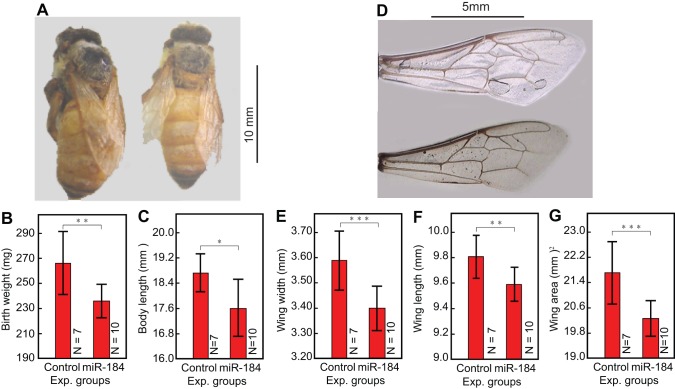
Morphological changes in honeybees treated with miR-184.Comparison between morphological characteristics of newly emerged adults of the miR-184 treated group and the control group: a). the miR-184 treated adult bee (right) and the control adult bee (left); b). the birth weight was significantly reduced by feeding miR-184 in larval food (F2,25 = 5.255, p = 0.0124, One-way ANOVA; p<0.0036, Tukey's test); c). the birth length was significantly reduced by feeding miR-184 in larval food (F2,25 = 4.051, p = 0.0299, One-way ANOVA; P = 0.0285, Tukey's test); d). wings of the miR-184 treated adult bee (Bottom) and the control adult bee (top); e). the wing width was significantly reduced by feeding miR184 in larval food (F2,25 = 8.496, p = 0.0015, One-way ANOVA; P = 0.0003, Tukey's test). f). the wing length was significantly reduced by feeding miR184 in larval food (F2,25 = 4.683, p = 0.0187, One-way ANOVA; P = 0.0055, Tukey's test). g). the wing area was significantly reduced by feeding miR184 in larval food (F2,25 = 9.307, p = 0.001, One-way ANOVA; P = 0.0002, Tukey's test). ***P<0.001; **P<0.01; *P<0.05. See text for details.